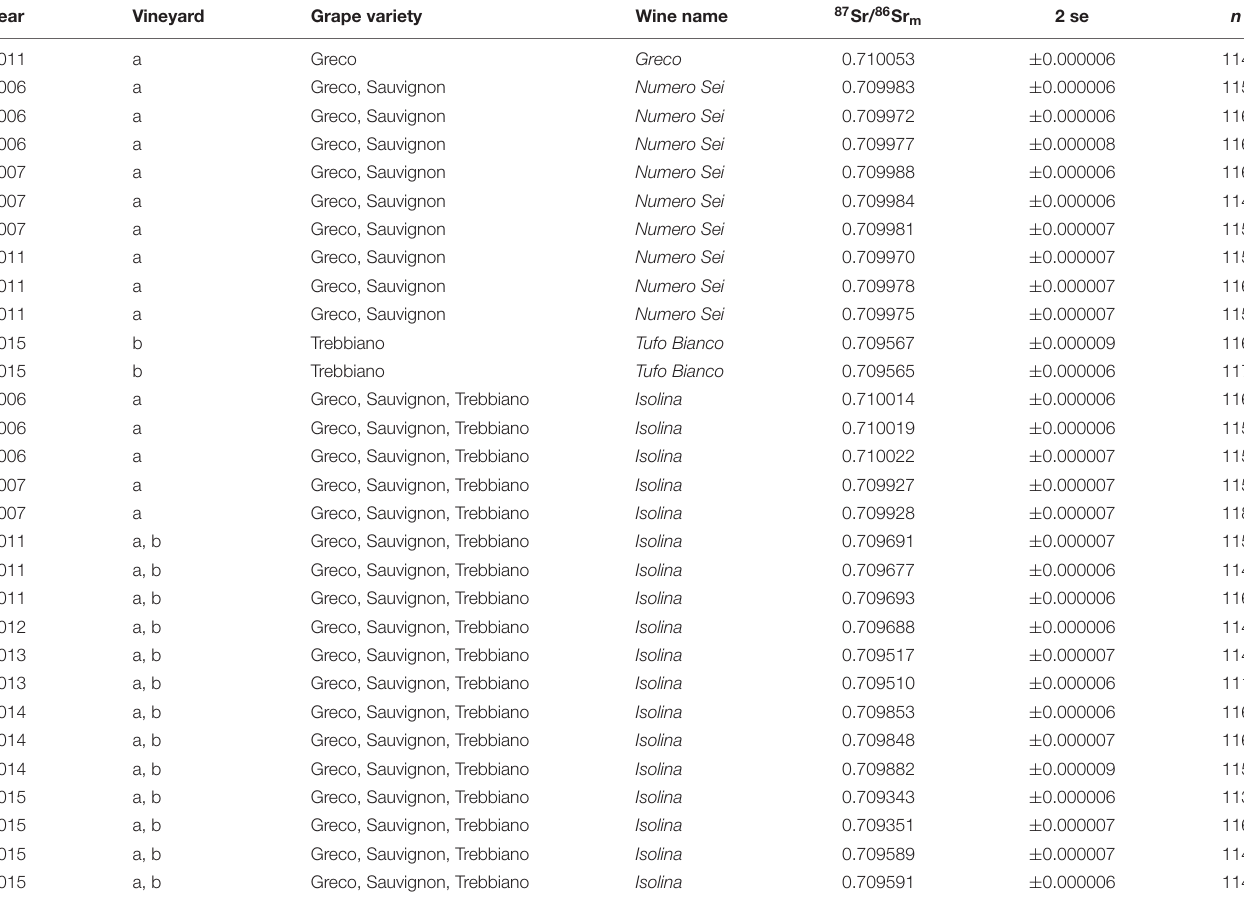
TABLE 1 | Isotopic composition of the analyzed wines from the Sassotondo winery divided by vintage years and grape variety, area of provenance. Year Vineyard Grape variety Wine